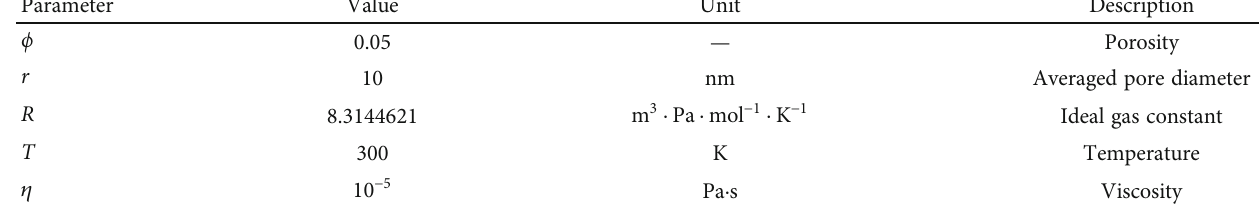
Table 2: Parameters of the model used in example 1.